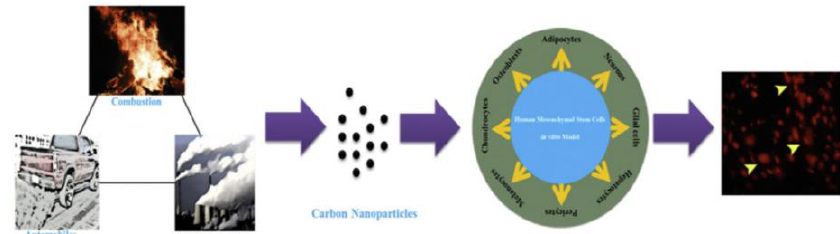
Figure 6: The sources of carbon nanoparticles and the cells that they affect